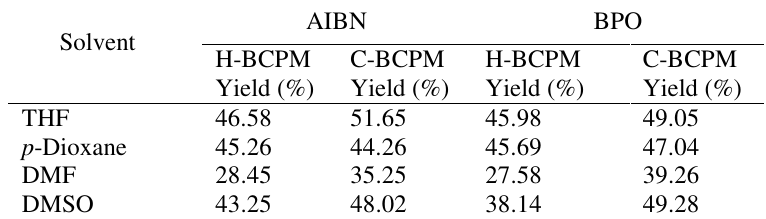
Table 2. Percentage yield of homo and copolymaleimide in various solvent-initiator systems.